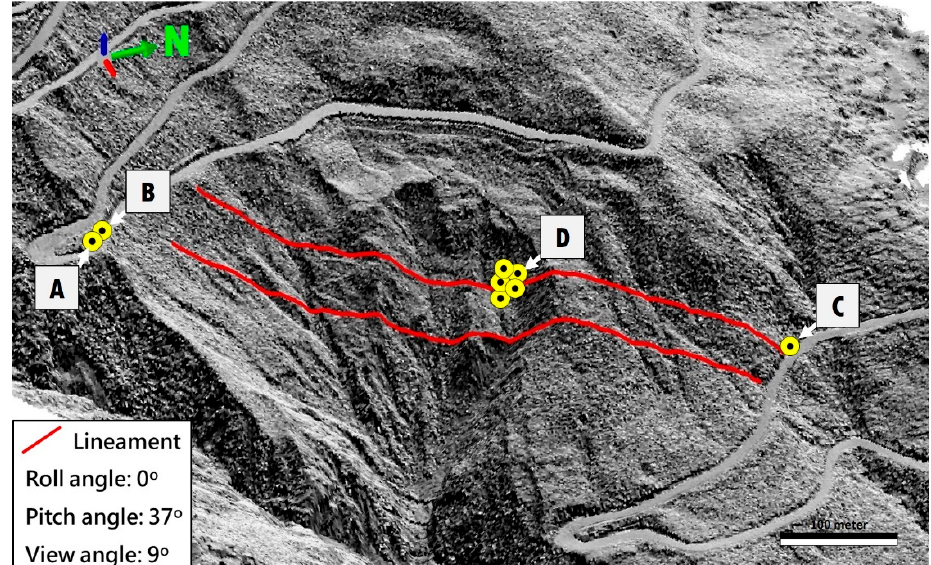
Figure 10. The three-dimensional shaded relief map derived from DTMH viewing from east direction toward west direction. Two lineaments were identified and marked by the red lines, the yellow dots marked the out-crop field investigation points A, B, C, and D.